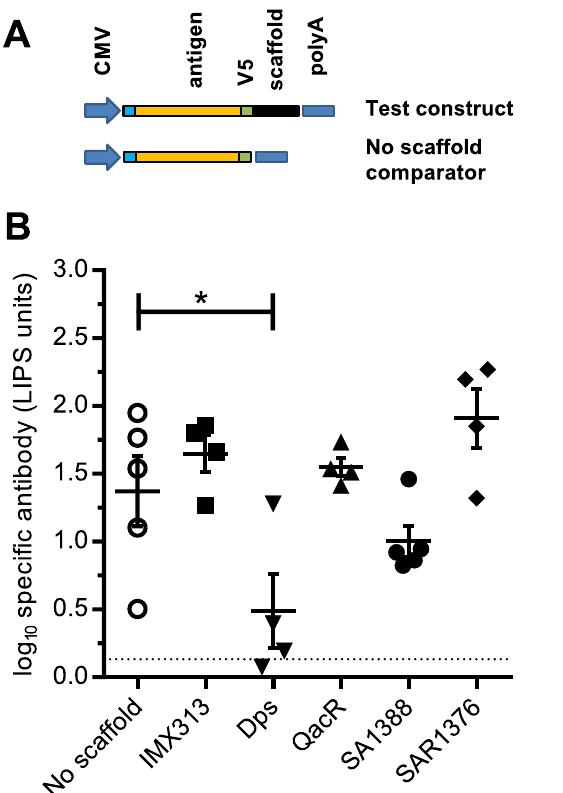
Table 1. DNA sequences of multimerising proteins investigated. All are human codon optimized. * Mutation in bold, underlined.